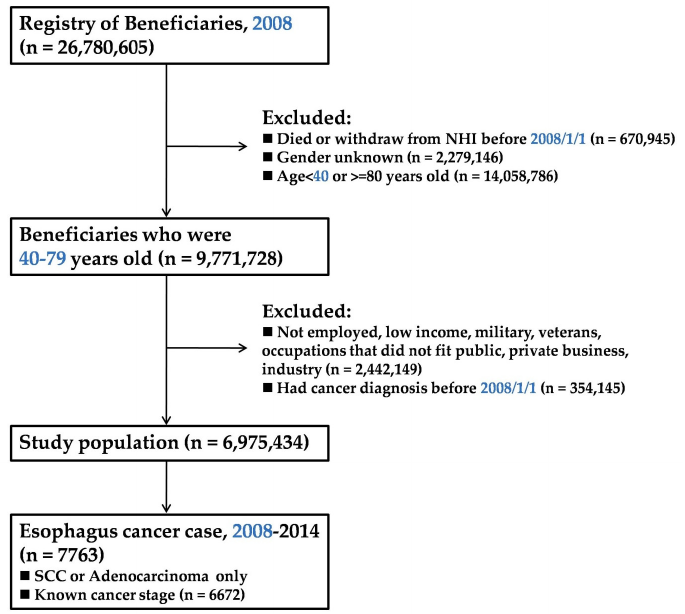
Figure 1. Flow chart for selection of the study population.